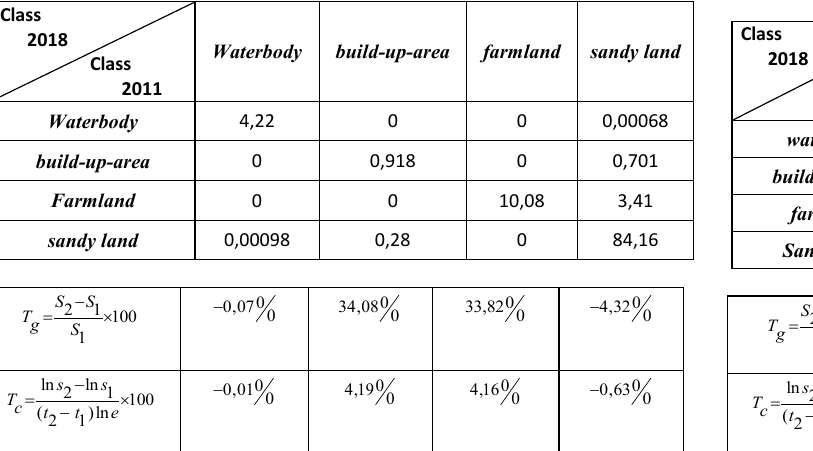
Table 3: Quantitative evaluation of land use changes during the period from 2011 to 2018